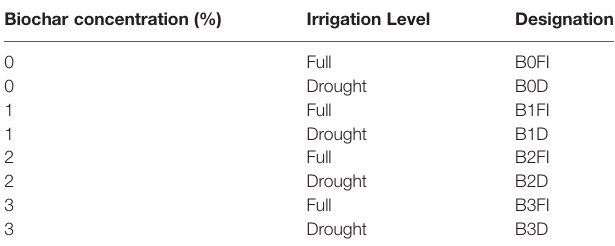
TABLE 1 | Treatment combinations. Biochar concentration